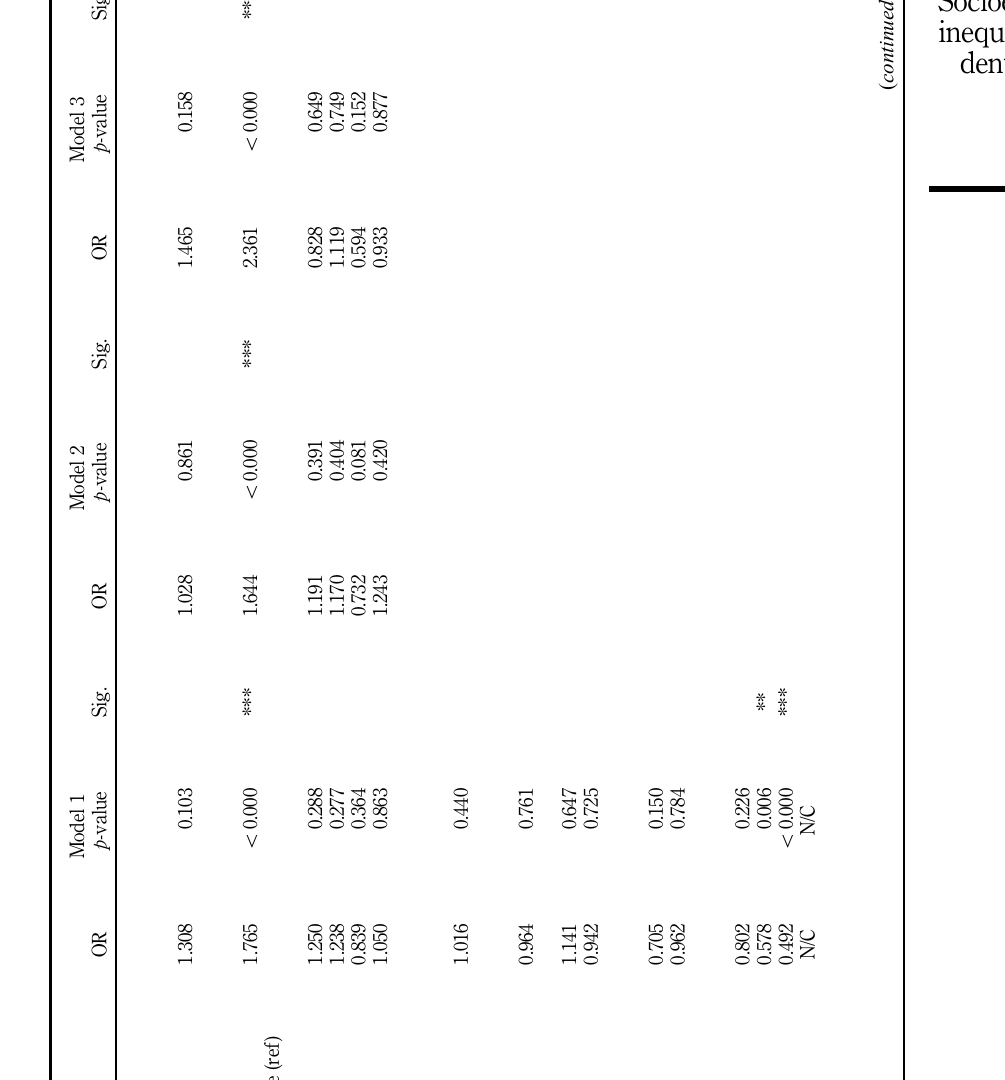
Table III. Multivariate